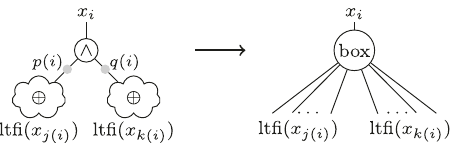
Fig. 8 Illustration of how sections of the XAG are compressed in a box node of the abstract